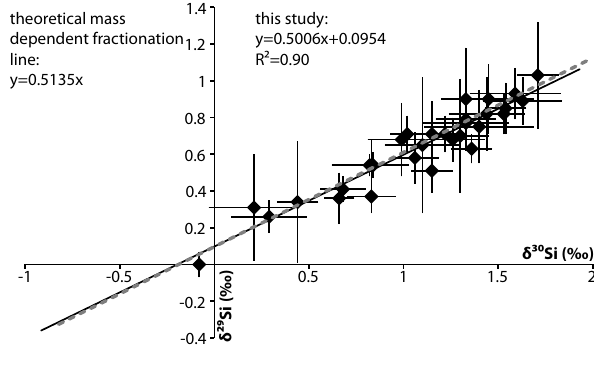
Fig. 2. δ 30 Si (‰) versus δ 29 Si (‰).